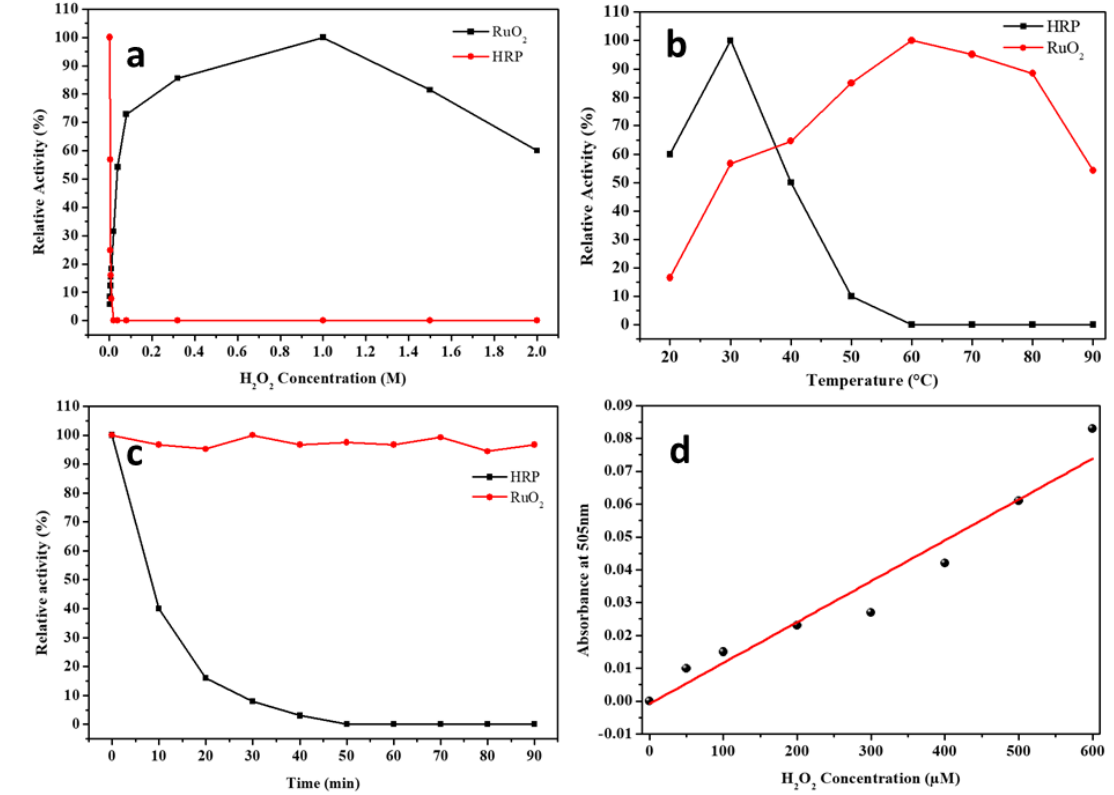
Figure 6. ( a ) H 2 O 2 concentration optima and ( b ) temperature optima plots, ( c ) thermal stability (at 80 °C for 90 min under the standard reaction conditions) and ( d ) sensitivity (at 505 nm for the different concentrations of H 2 O 2 ) of ruthenium oxide nanoparticles.